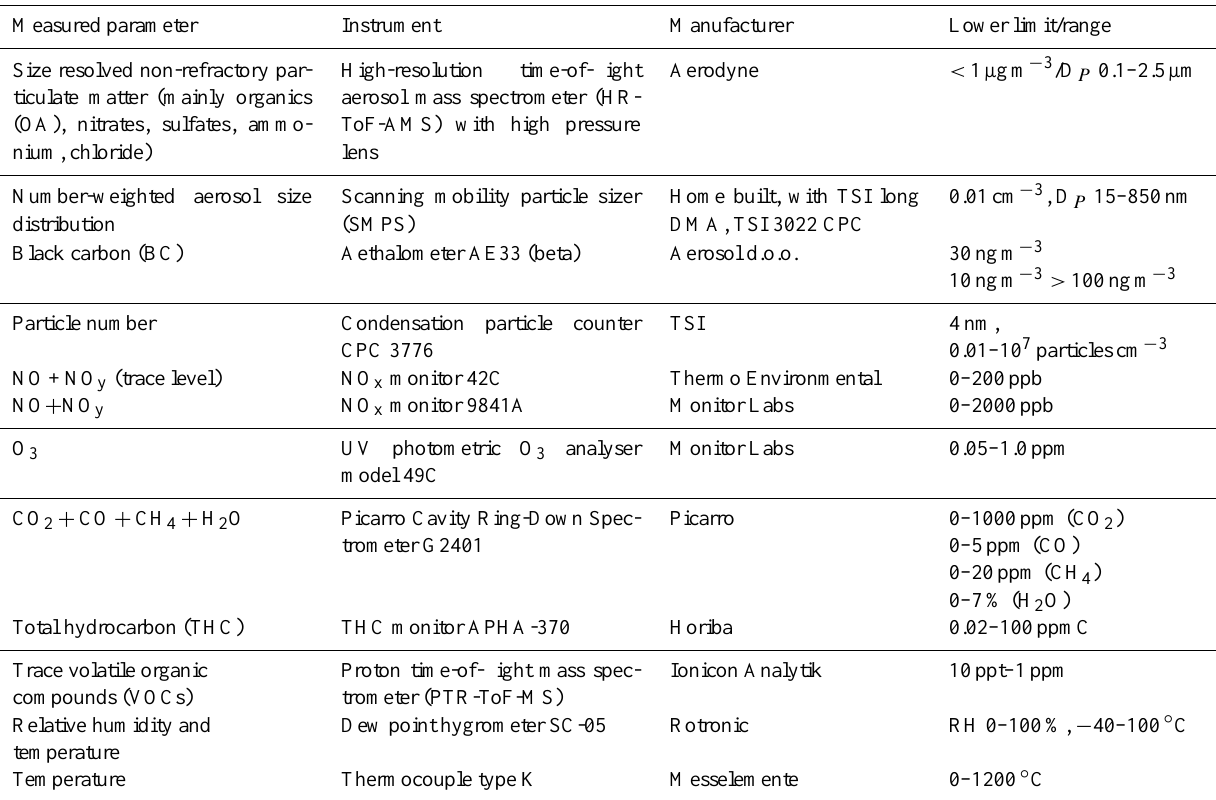
Table 1. Overview of instrumentation used to study the aging of emissions in the mobile smog chamber. Measured